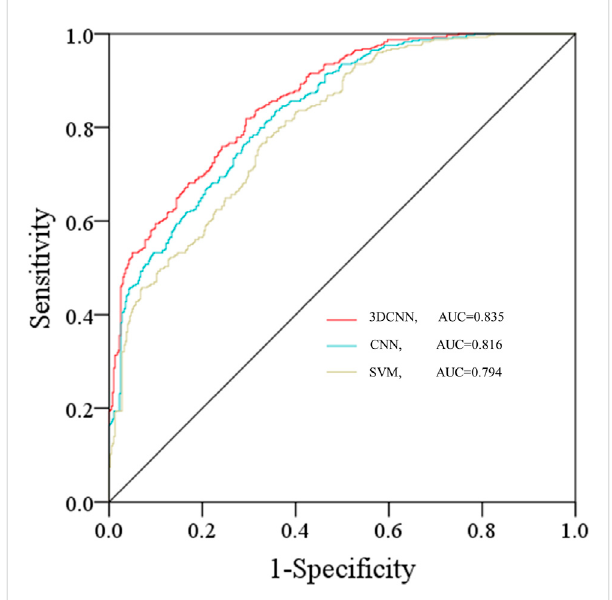
FIGURE 7 The ROC curve of three models with the 15 × 15 size of input